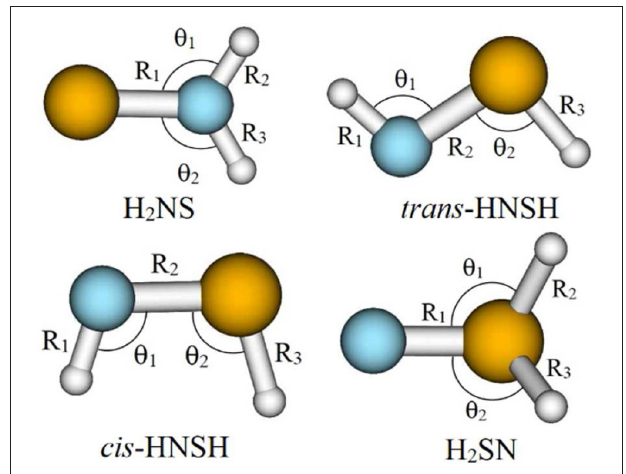
FIGURE 1 | Optimized stable forms of the H 2 NS species and definition of their internal